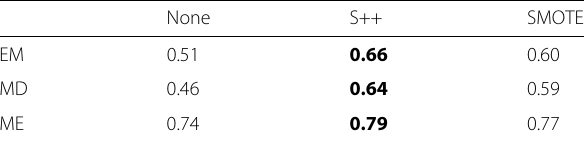
Table 5 The AUC values obtained with different filters for the EM, MD, and ME attack